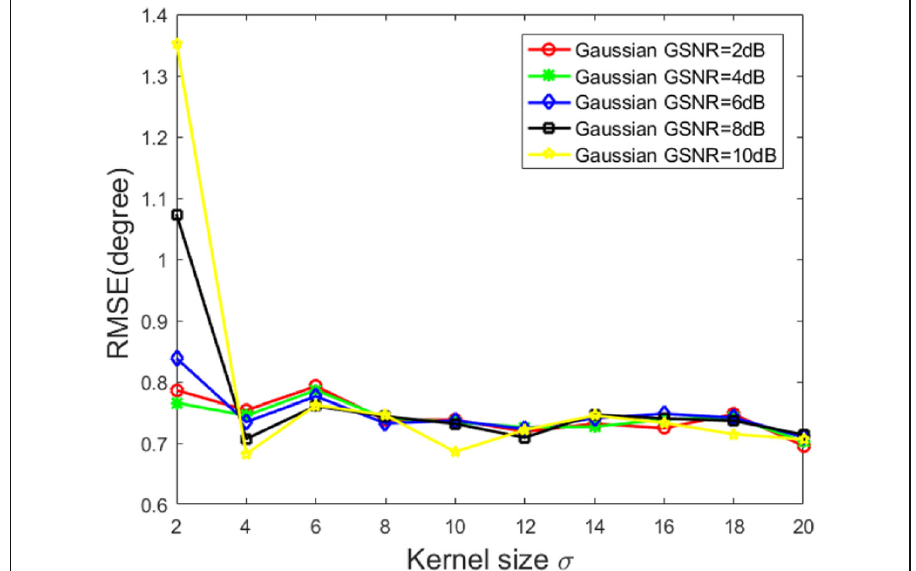
Fig. 11 RMSE against kernel size σ under different